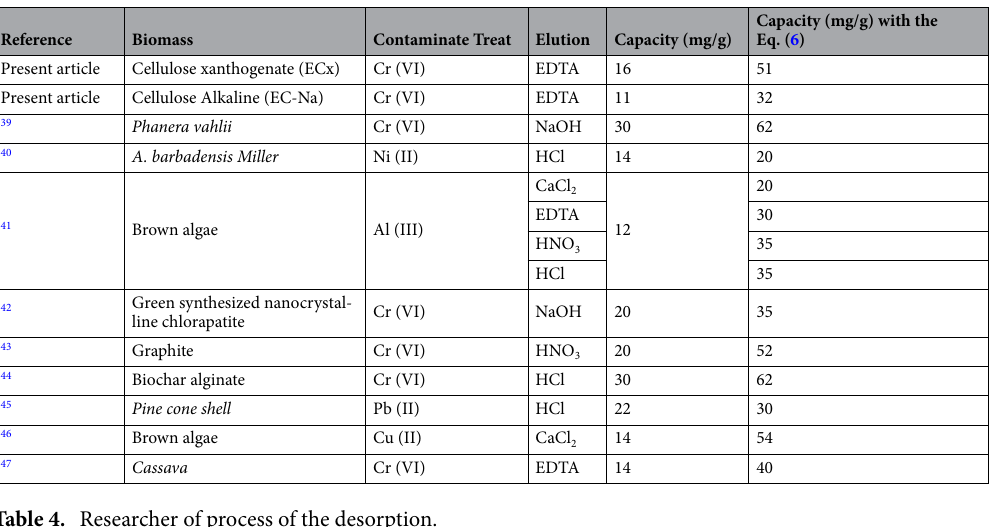
Table 4. Researcher of process of the